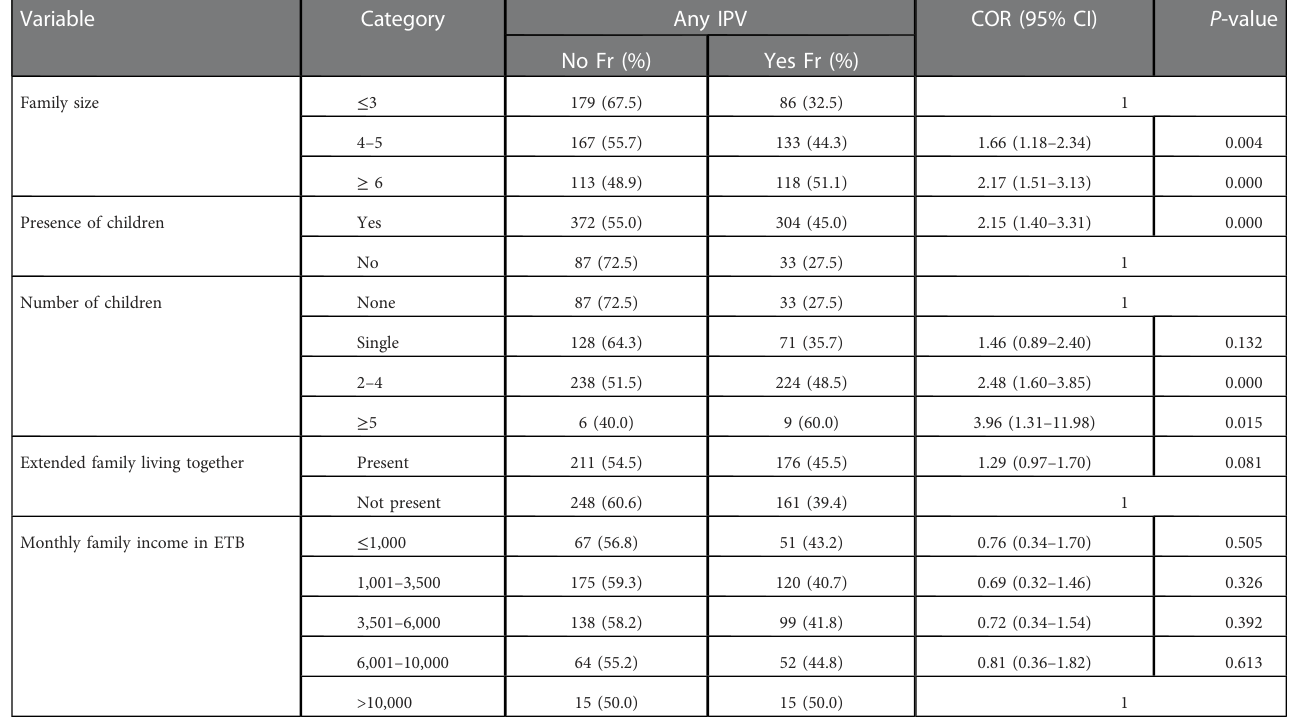
TABLE 7 Bivariate logistic regression analysis of the association of family-related factors with IPV among women of reproductive age in Debre Berhan, 2021 ( n =796).